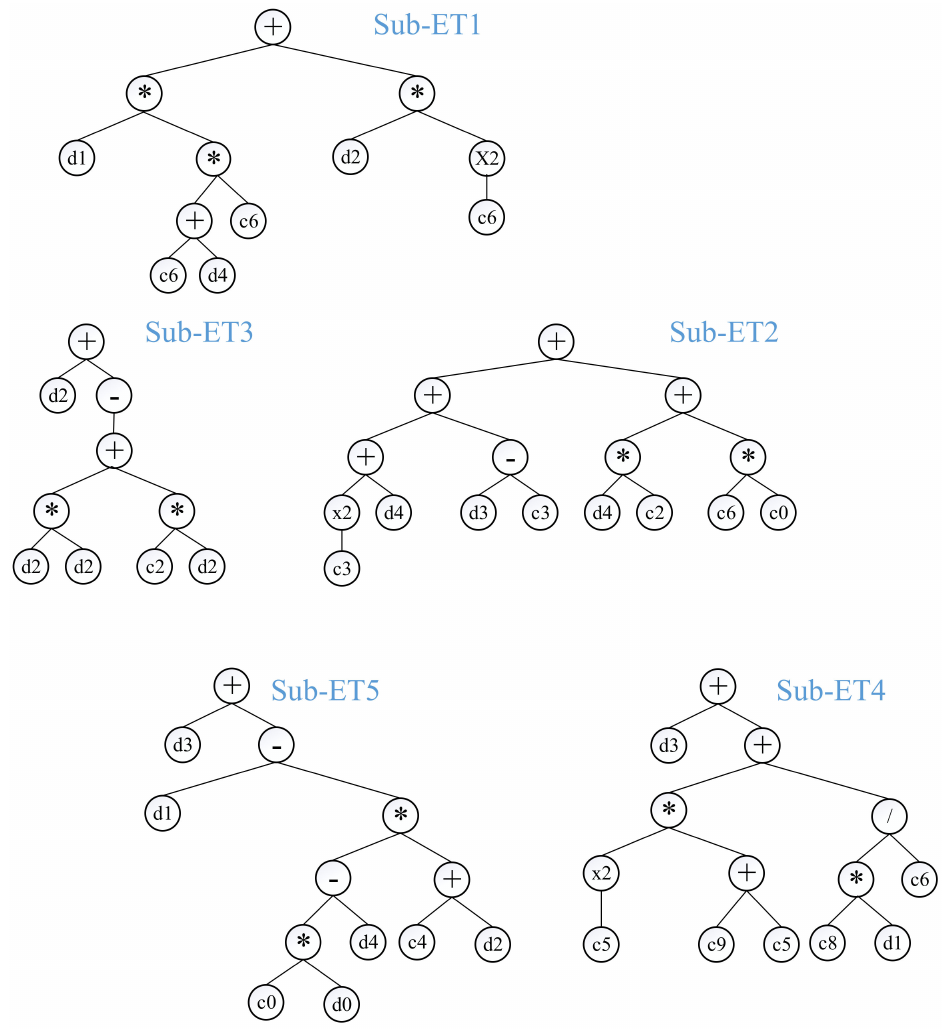
Figure 2. Expression trees (ETs) of the GEP model in the current study (* denotes multiply sign, / denotes division, +, and − denote addition and subtraction, respectively). Table 3. Setting parameters for the ANN